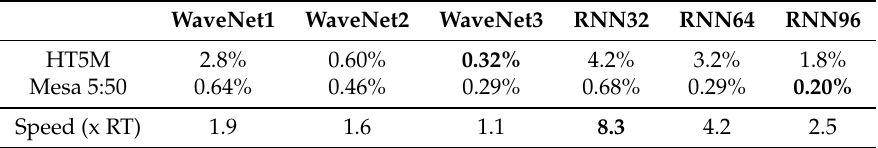
Table 2. Error-to-signal ratio for the test set and model processing